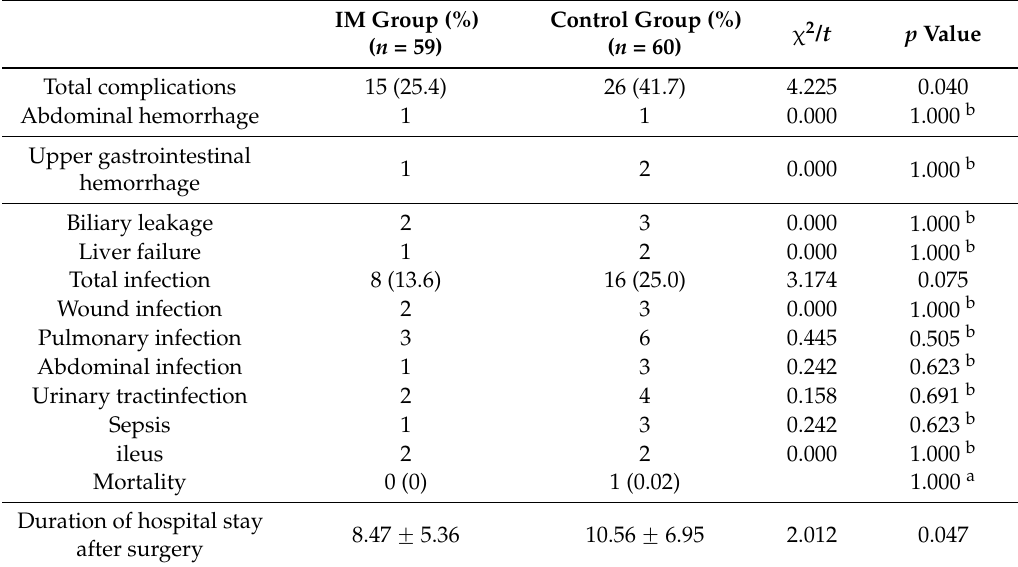
Table 3. Complications, mortality, and duration of hospital stay after surgery between two